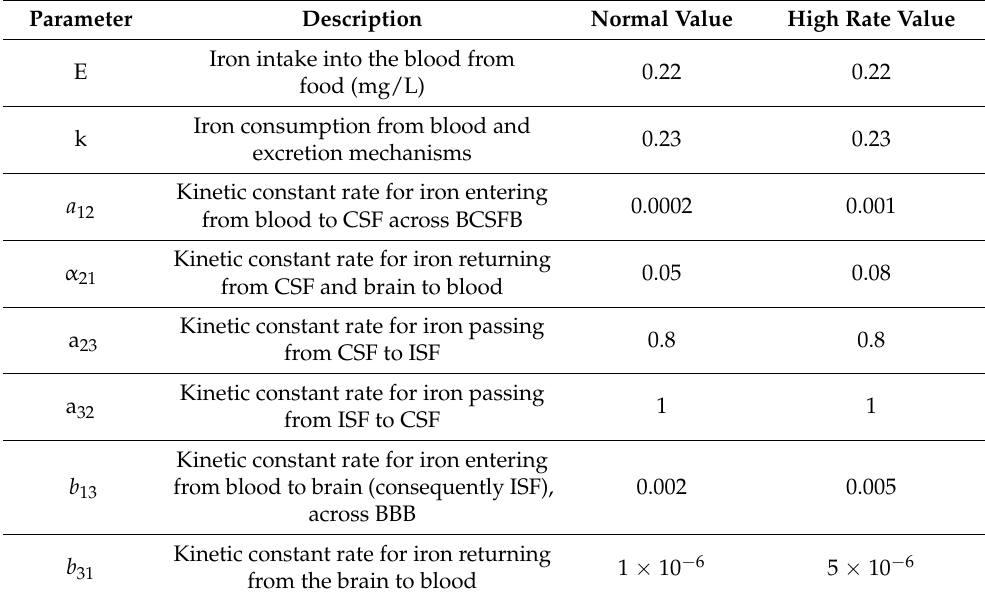
Table 1. Description and value of parameters used for the equations.